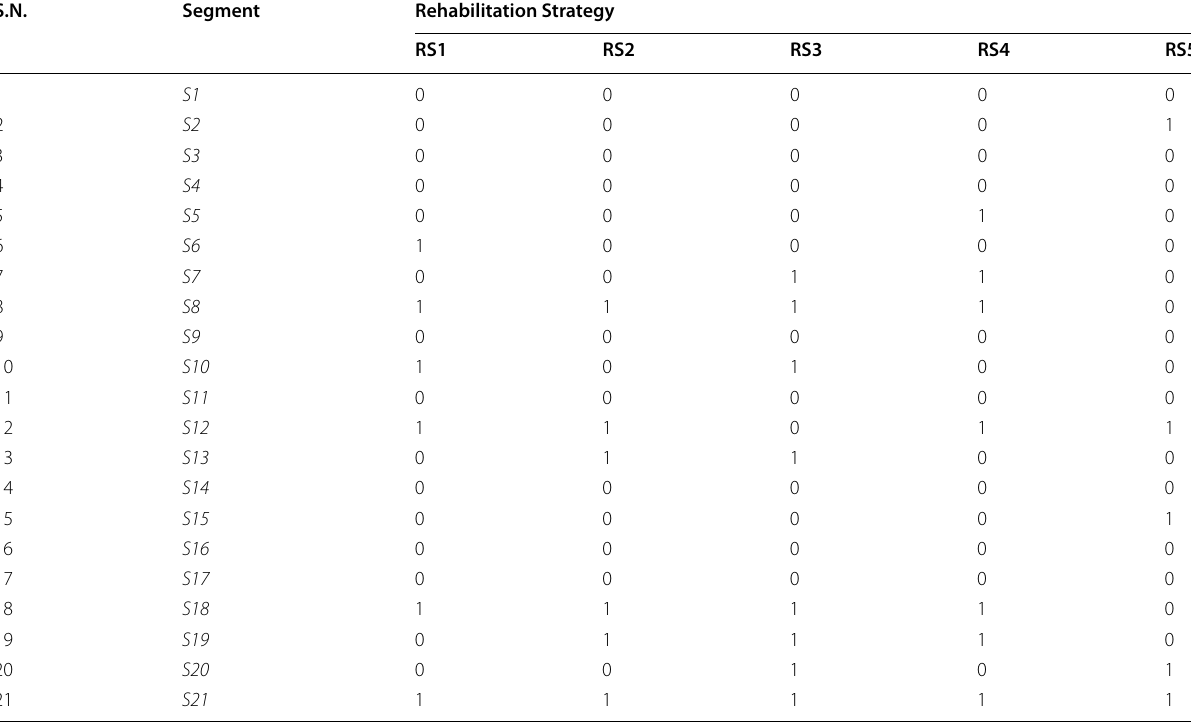
Table 3 Slopes rehabilitated under strategies RS1, RS2, RS3, RS4, and